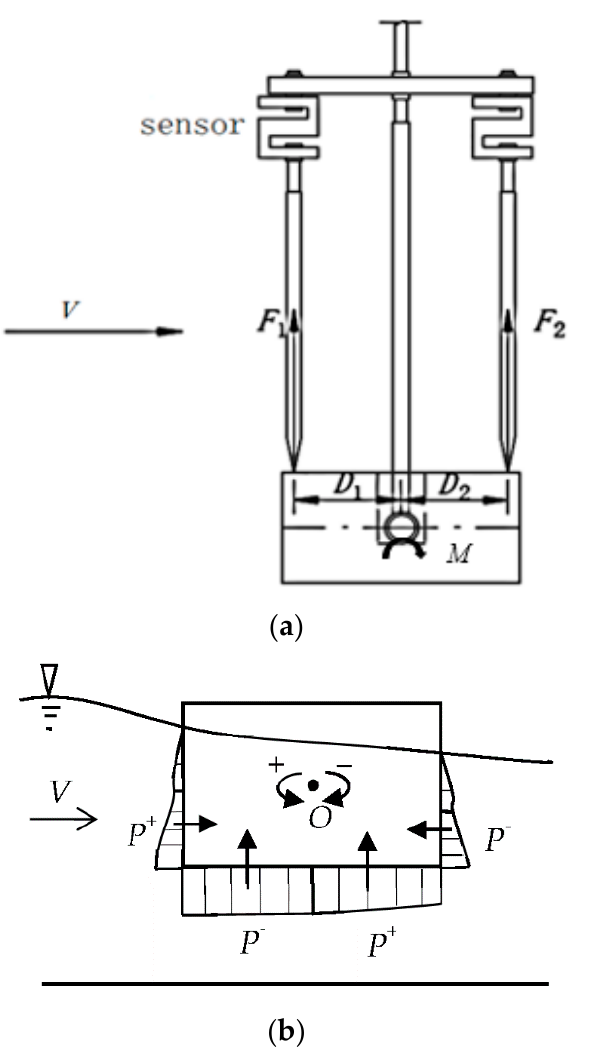
Figure 2. Schematic of moment measurement: ( a ) Layout of the sensor, ( b ) Pressure profile of the floating structure.